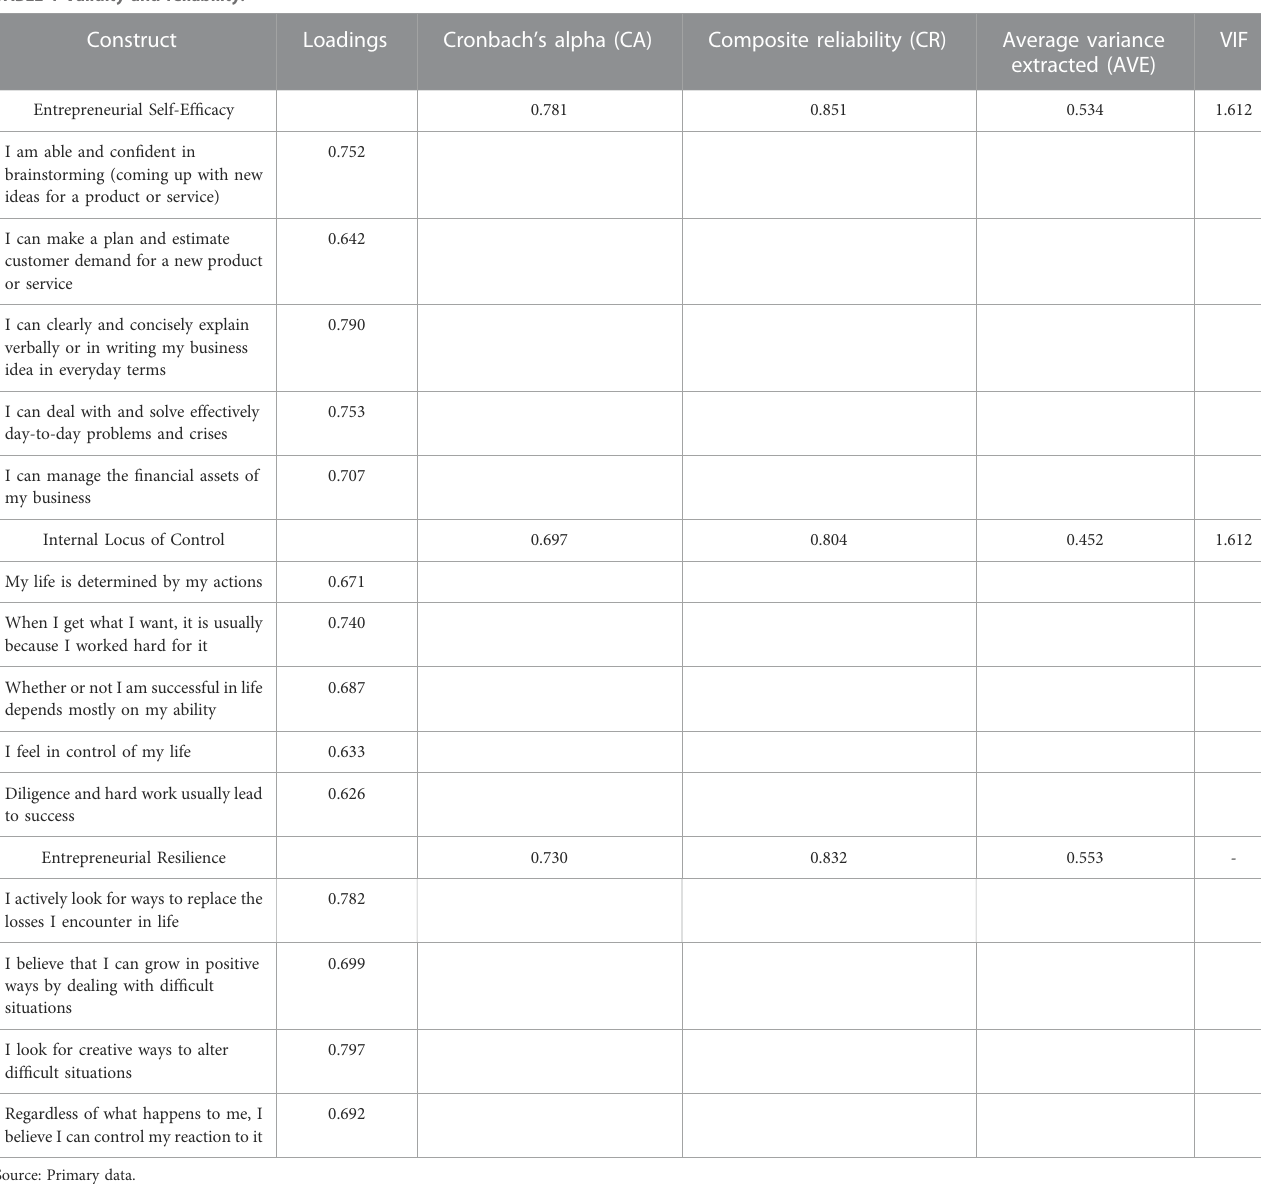
TABLE 1 Validity and reliability.